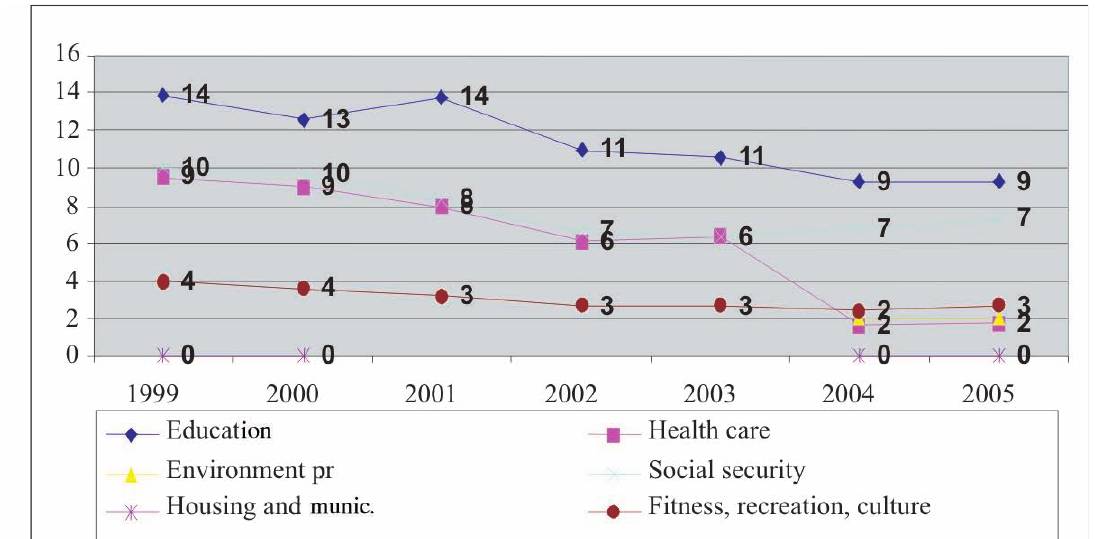
Fig 2. Lithuania’s state budget expenditure for fields dominated by women, %